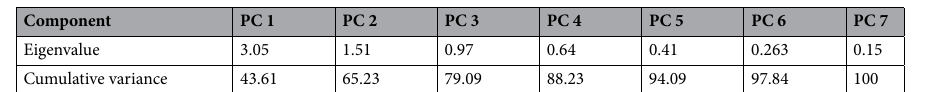
Table 2. Principal components and the explained variance in the genetic diversity of traits related to technological properties of natural rubber latex, used in the evaluation of the 44 rubber tree genotypes. The first three principal components explained 80% of the variation among